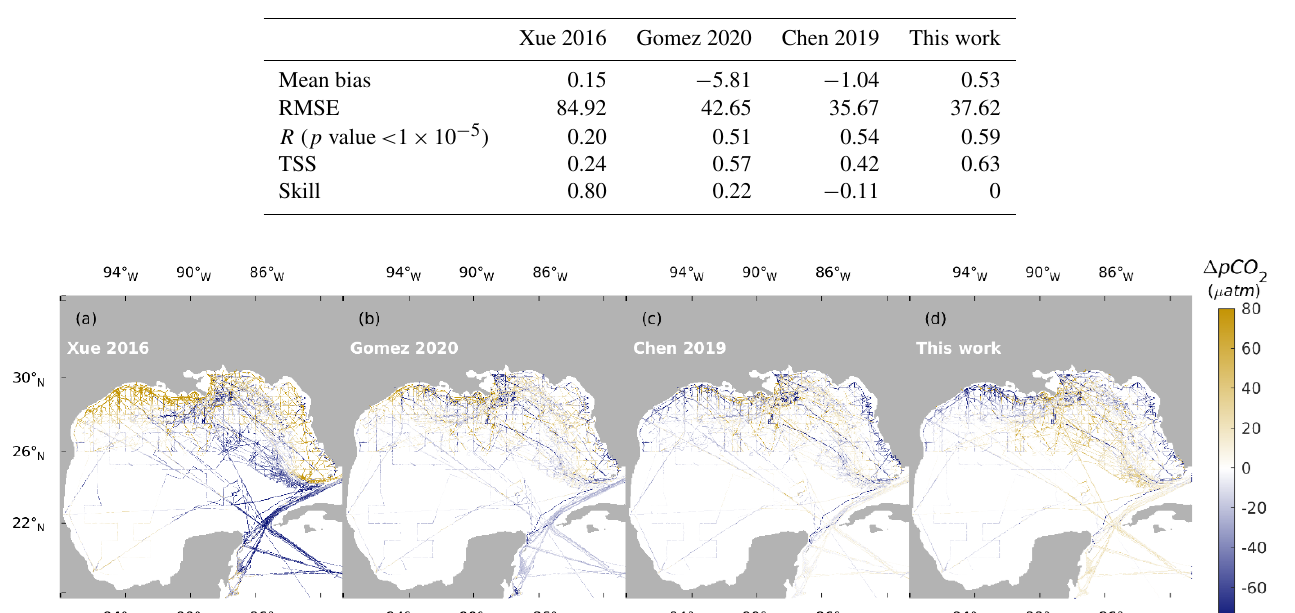
Table 2. Statistics of surface p CO 2 comparison.